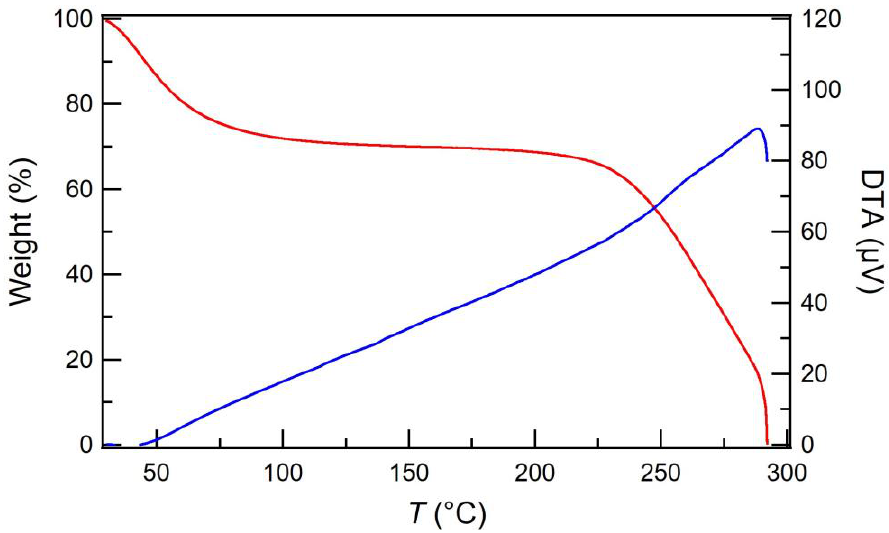
Figure 2. TGA (red) and DTA (blue) curves of the pristine ESM.